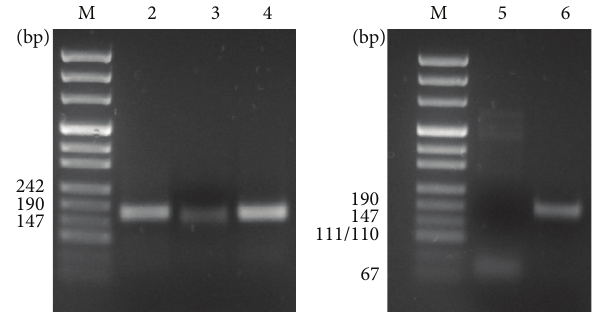
Figure 1: Identification of ANP, BNP, NPR-1, AQP1, and AQP5 transcripts in BEAS-2B cells. qReal-Time PCR was performed using gene specific primers for ANP (lane 2), BNP (lane 3), NPR-1 (lane 4), AQP1 (lane 5), sand AQP5 (lane 6) in BEAS-2B cells. Single bands of the predicted molecular size for ANP (160bp), BNP (148bp), NPR-1 (151bp),AQP1(98bp),andAQP5(180bp)transcriptsweredetected. Lane M: DNA molecular